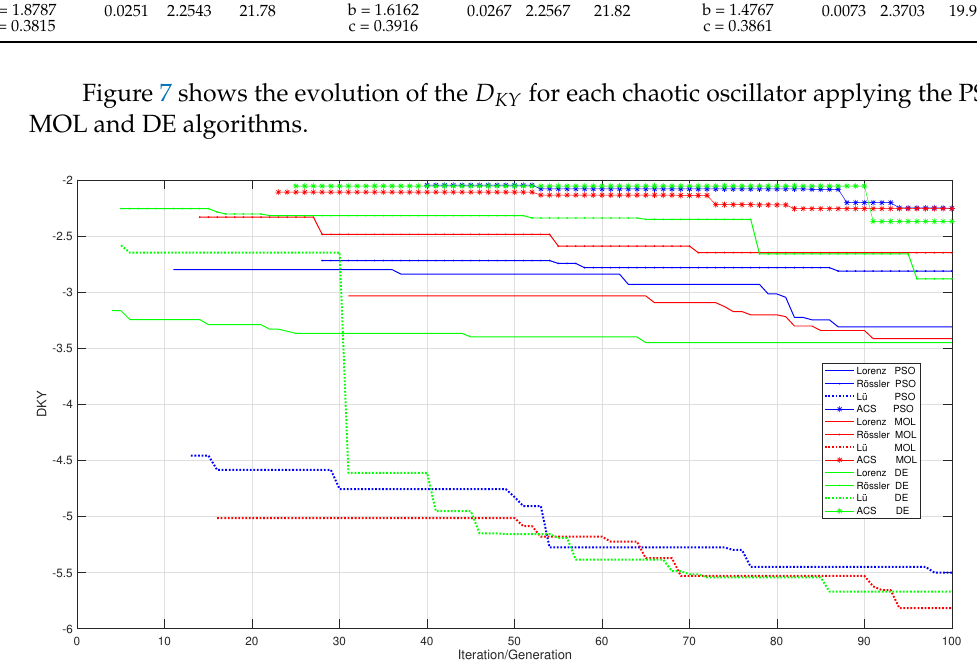
Figure 7. Best global evolution of the D KY for the four chaotic oscillators applying PSO, MOL and